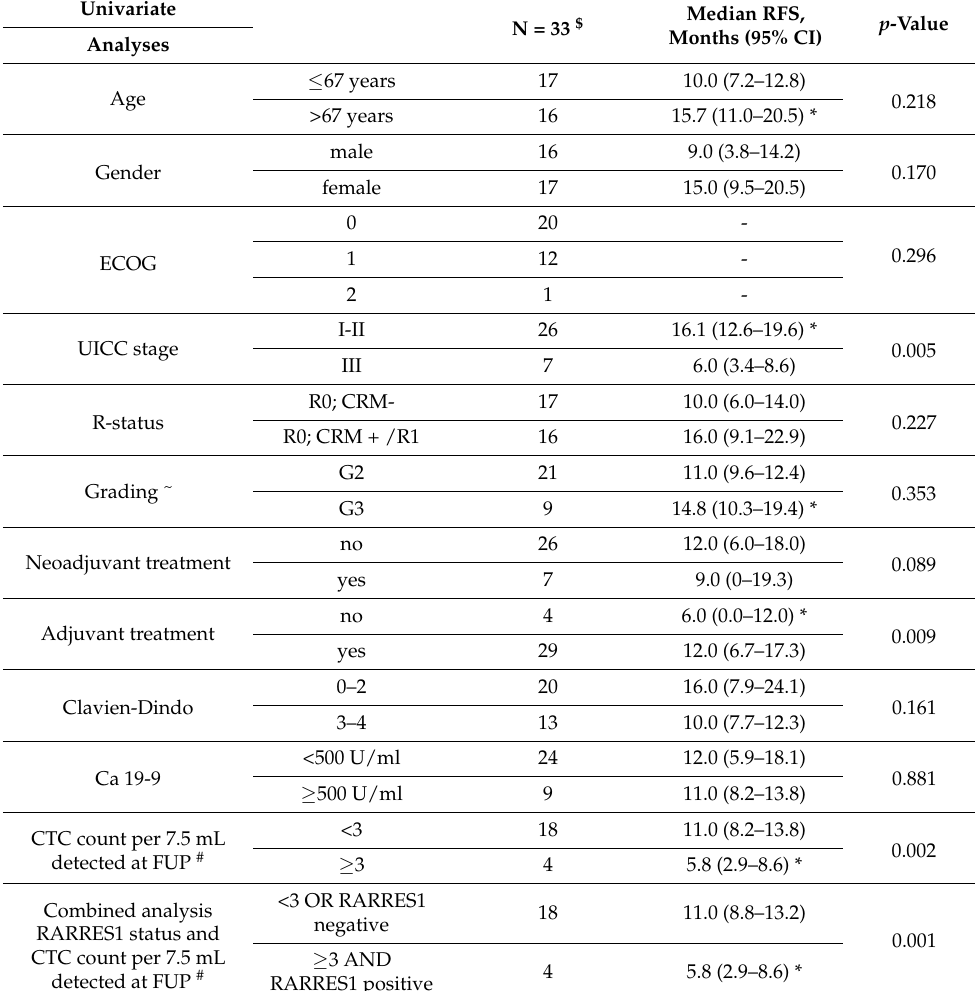
Table 1. Univariate analysis of recurrence-free survival in curative